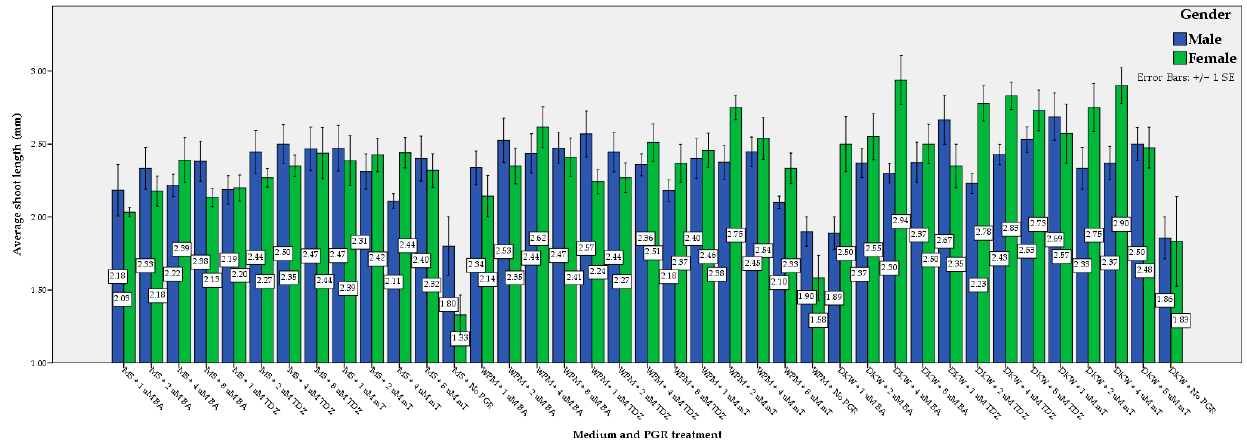
Maximum average shoot length per explant in the female explants was achieved